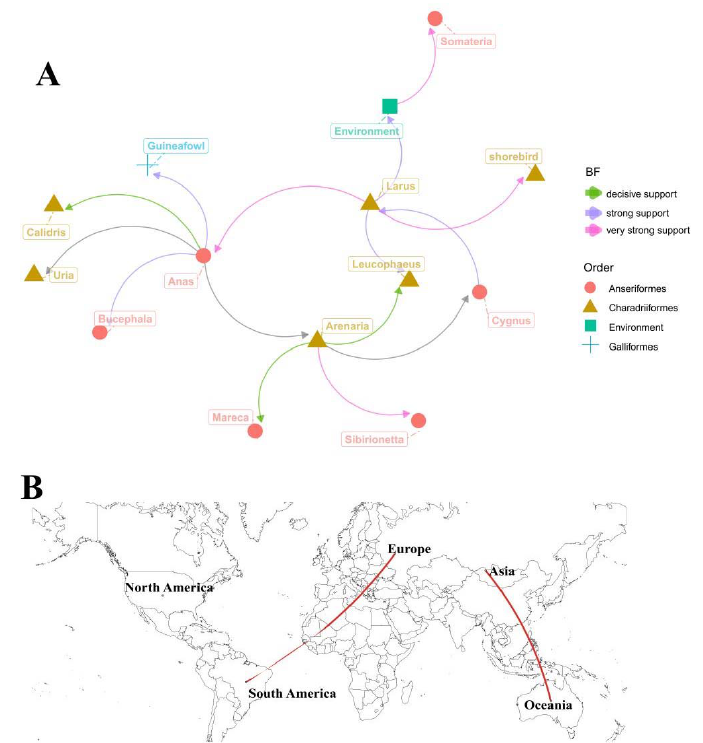
Figure 4. Host and spatial diffusion of H12 IAVs. Major hosts ( A ) and migration routes ( B ) of the viral transmission were determined based on the established criteria (BF > 3 and the posterior probability >0.5). Values of 3 ≤ BF < 10, 10 ≤ BF < 100, 100 ≤ BF < 1000, and BF ≥ 1000 indicated substantial, strong, very strong, and decisive support,